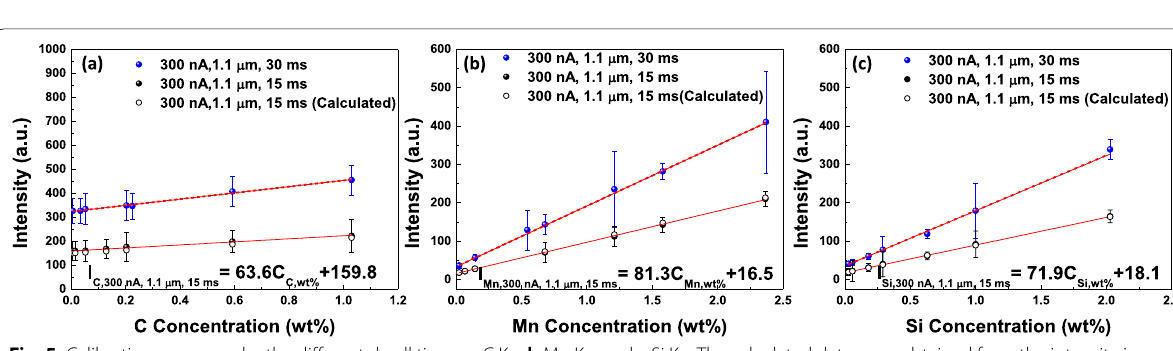
Fig. 5 Calibration curves under the different dwell times; a C Kα, b Mn Kα, and c Si Kα. The calculated data were obtained from the intensity in 1 10 − 7 A probe current and 30 ms by dividing ×